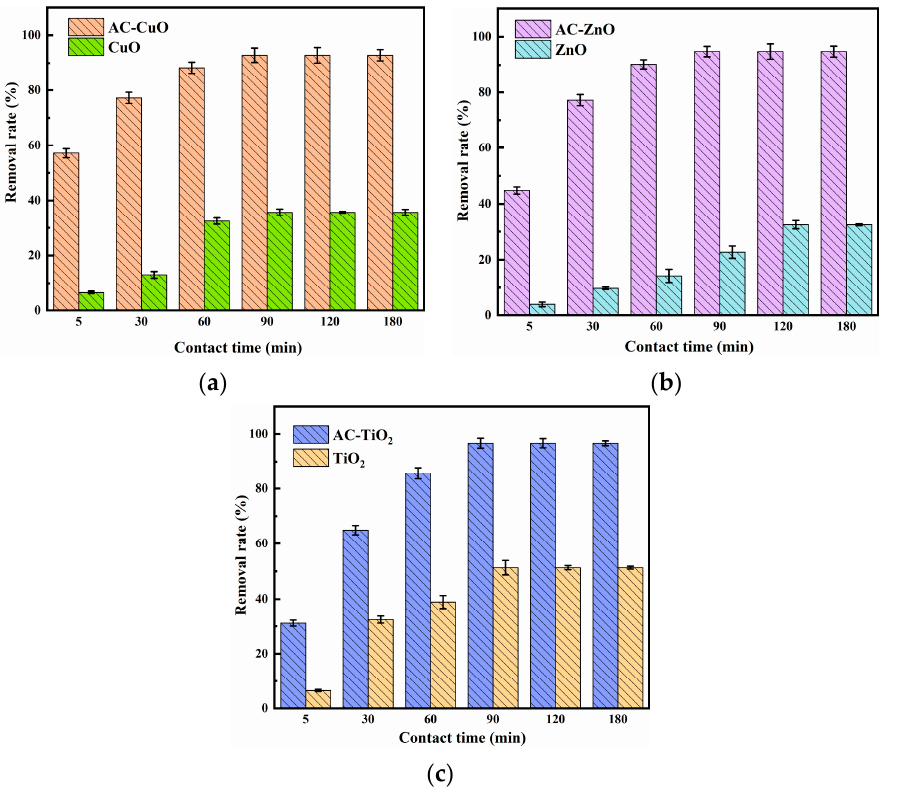
Figure 10. The effect of ( a ) AC-CuO; ( b ) AC-ZnO; ( c ) AC-TiO 2 contact time on the removal of methylene blue (initial concentration = 5 mg/L, dosage = 1 g/L, temperature = 25 ±0.5 °C, initial pH = 7.00).